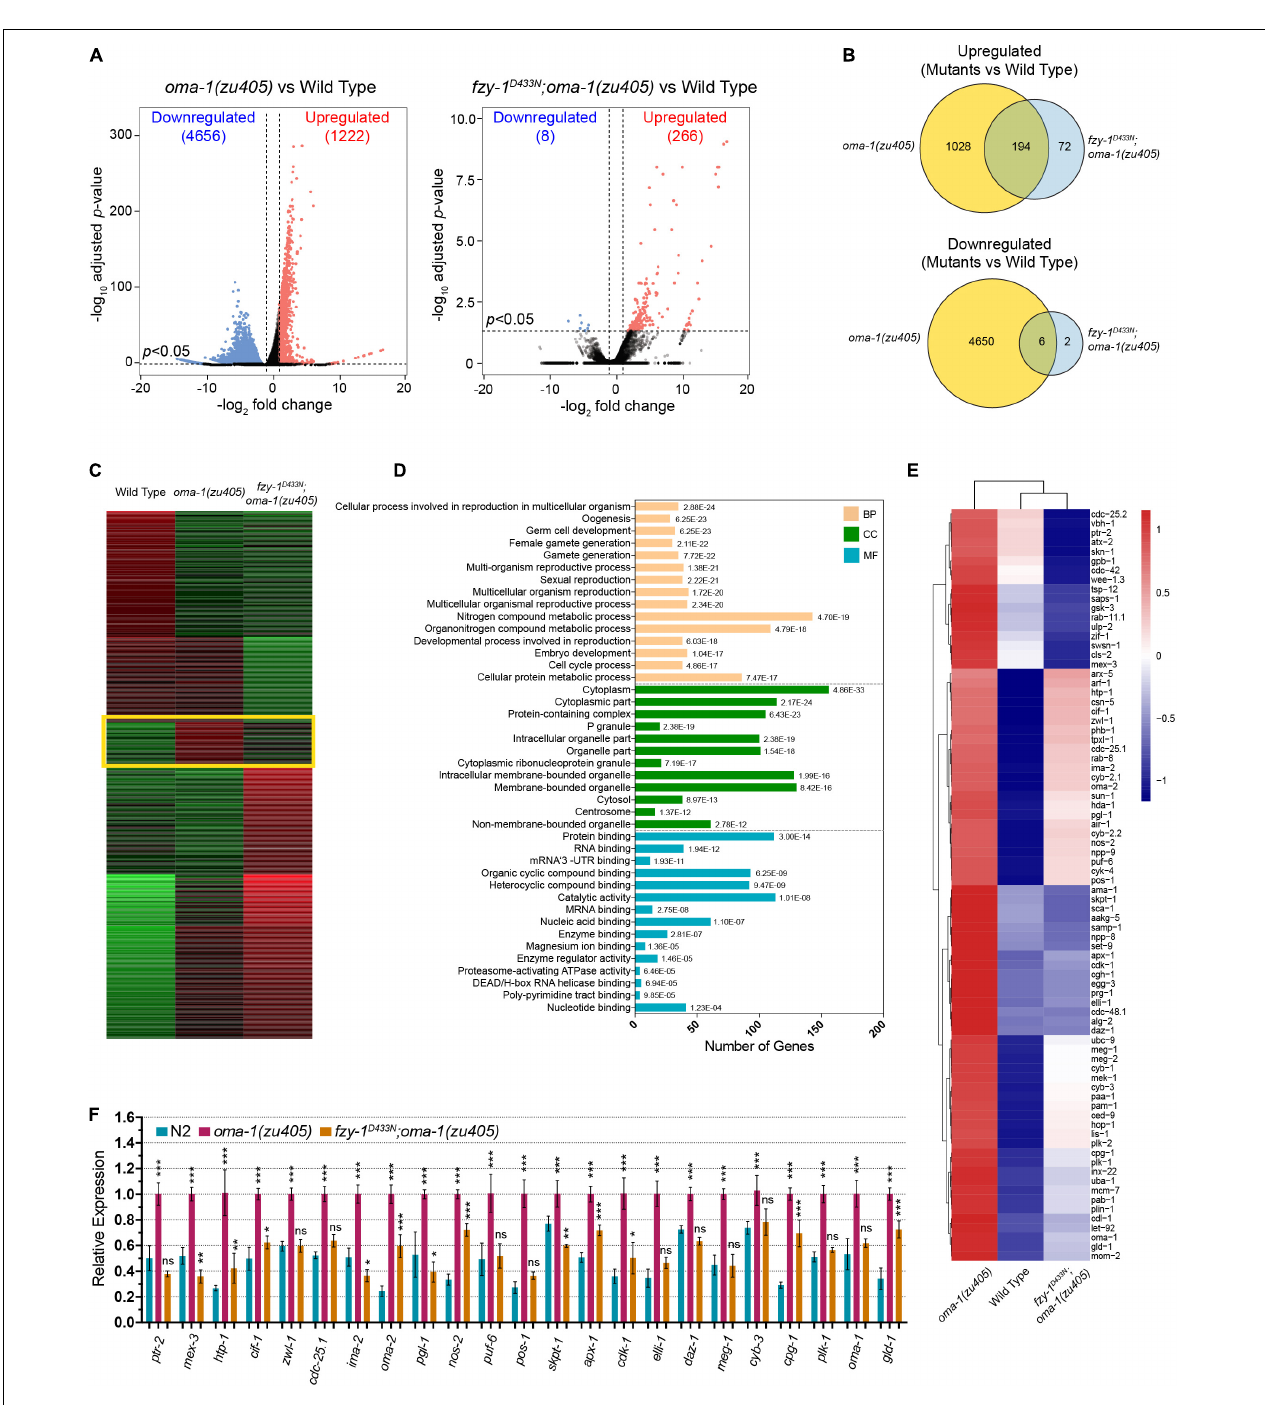
FIGURE 3 | Comparative transcriptome analysis of oma-1(zu405) , fzy-1 D 433 N ;oma-1(zu405) , and the wild type. (A) Volcano plots of all differentially expressed genes detected in the mRNA-seq data in oma-1(zu405) (left) and fzy-1 D 433 N ;oma-1(zu405) (right), compared to the wild type. Criteria of deferential expression was | log 2 (fold change)| > 2, and Benjamini-Hochberg adjusted p -value < 0.05. (B) Venn diagrams depict the number of genes that are upregulated (or downregulated) only in oma-1(zu405) or fzy-1 D 433 N ;oma-1(zu405) or in both. (C) K -means cluster analysis of differentially expressed genes. The group of genes highlighted in the yellow rectangle show similar expression levels in fzy-1 D 433 N ;oma-1(zu405) and wild type strains. Expression levels were calculated as RPKM-normalized values. Each row represents a differentially expressed gene. (D) GO enrichment analysis of genes within the yellow rectangle in panel (C) . Category distribution of the 318 differentially expressed genes is shown for three GO domains: biological process (BP), molecular function (MF), and cellular component (CC). (E) The heatmap shows differential expression of 80 genes, which were assigned to the terms of germ cell development, embryo development, protein binding, and RNA binding in panel (D) . (F) Quantitative real-time PCR measurements of expression levels of selected 23 genes from (E) in the indicated strains. The results are presented as the average ± S.D. * p < 0.05; ** p < 0.01; *** p < 0.001; ns: not significant. The p -values were calculated by 2-way ANOVA followed by Dunnett’s multiple comparisons.